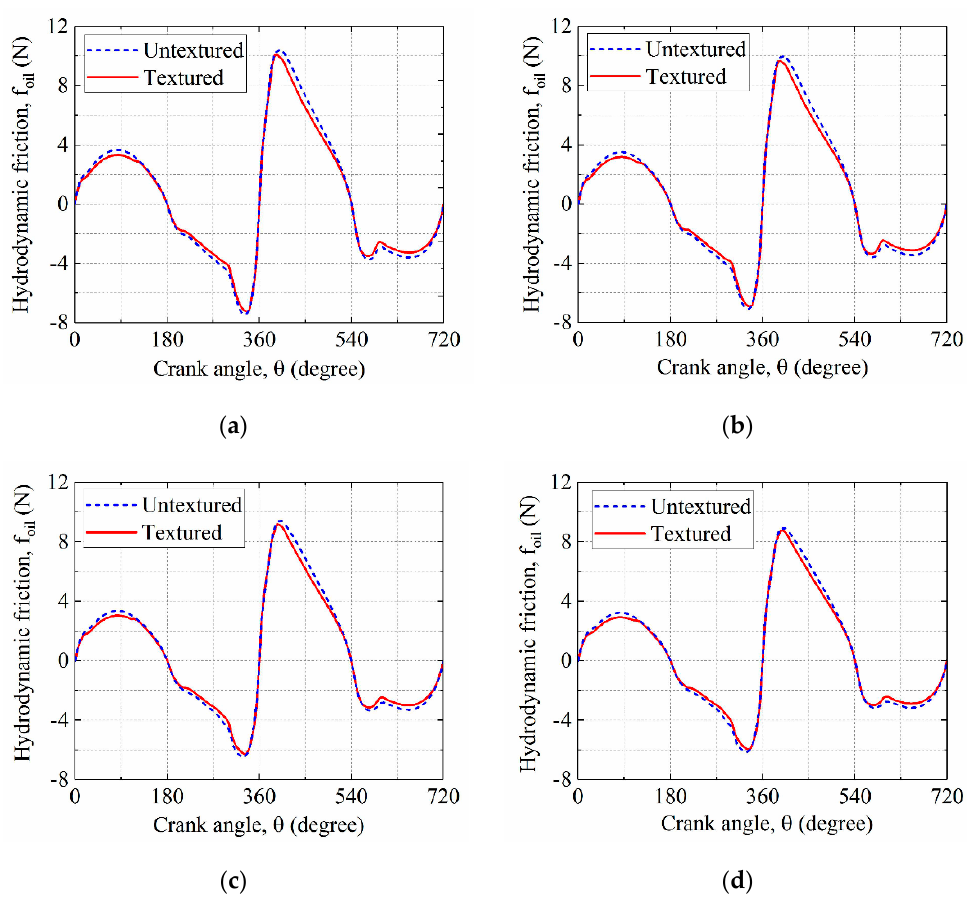
Figure 10. Hydrodynamic friction forces in the textured RLC and untextured RLC: ( a ) ∆ c is 0 µ m; ( b ) ∆ c is 10 µ m; ( c ) ∆ c is 20 µ m; and ( d ) ∆ c is 30 µ m.